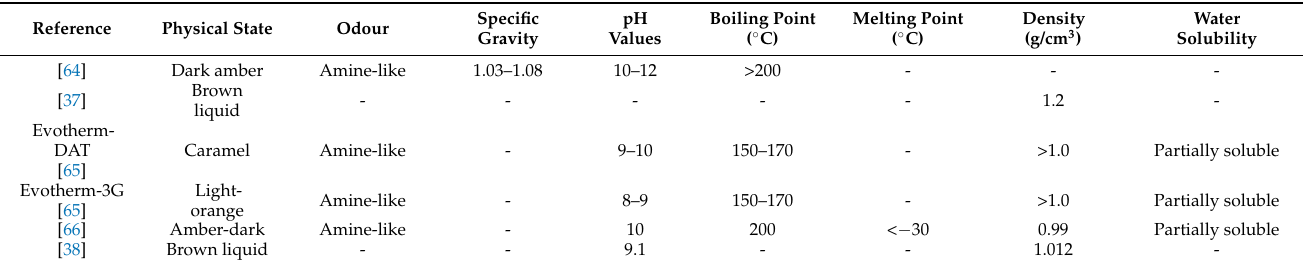
Table 6. Properties of Evotherm based on previous studies.